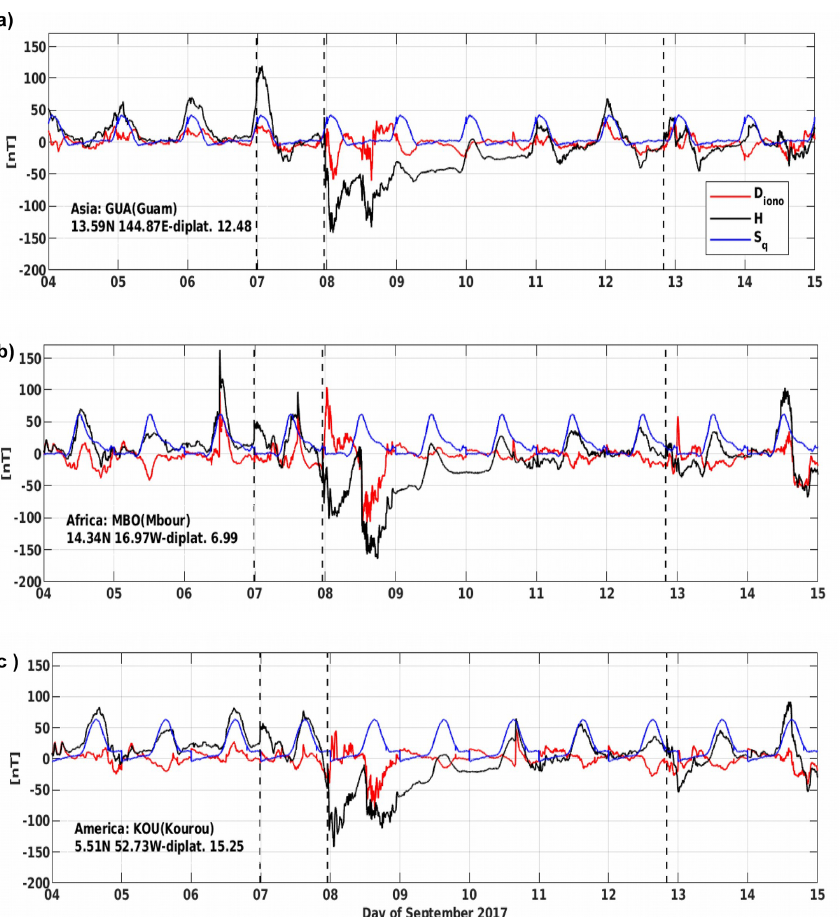
Figure 5. The magnetometer H variations at specific stations during 4–14 September 2017 over the three sectors: the Asian (a) , the African (b) and the American (c) . On each plot the quiet daily variations S q (in blue), the actual H variations (in black) and the varia- tions due to disturbed ionospheric currents D iono (in red) are plotted.